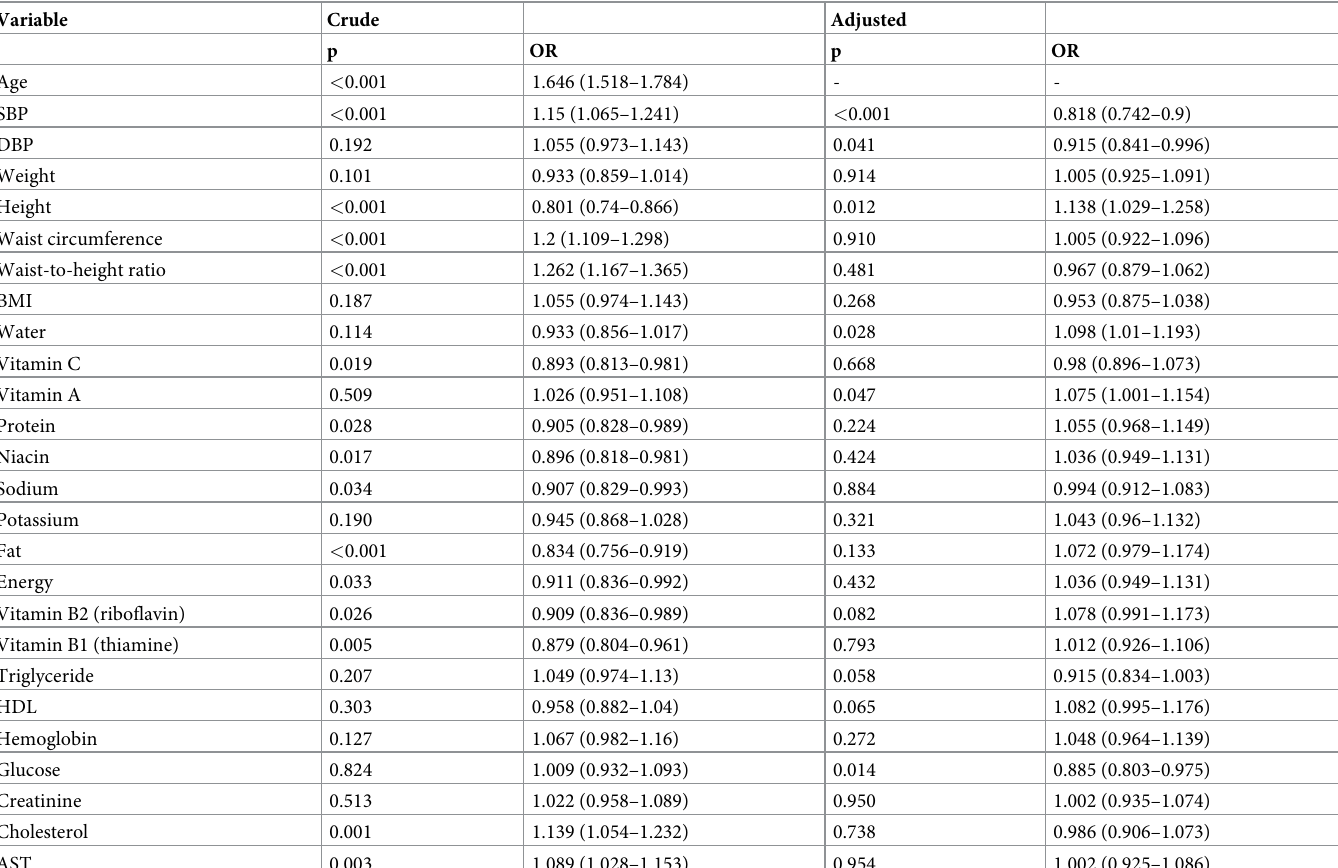
Table 3. Association of PUD with obesity indices, nutrients, and blood parameters in Korean